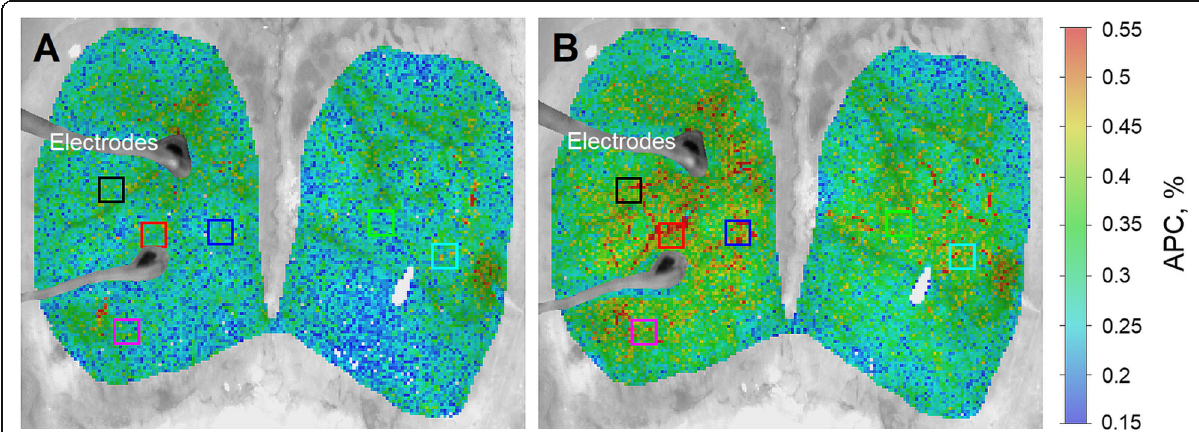
Fig. 2 Pseudo-colored maps of the electrical stimulation-evoked changes in APC over the cortical surface at 530 nm. a Spatial distribution of APC overlaid with the initial cortex image as estimated at the beginning of the pre-stimulation phase (10th s of the trial). b APC mapping during stimulation (30th s of the trial). The color bar on the right shows APC as a percentage, which is the same for both panels ( a ) and ( b ). Colored squares show the position of selected regions (big regions of interest) in which changes in mean APC were assessed to monitor the parameter ’ s